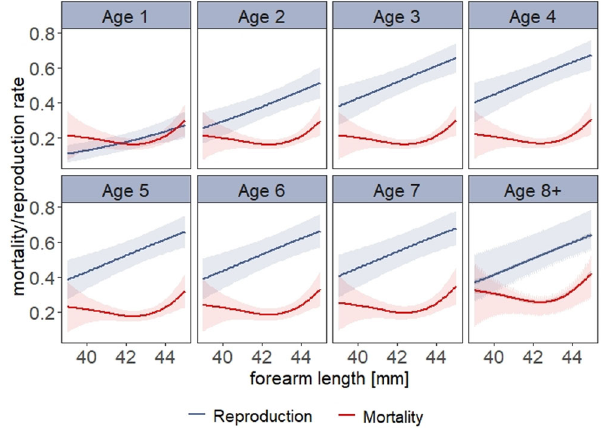
Fig. 4 Trajectories of mortality and reproduction with body size. Predicted response of the reproduction (blue) and mortality (red) increase in dependence of body size (forearm length (mm)). All underlying GAMs are calculated with k = 10, Gamma = 1.4 and method =